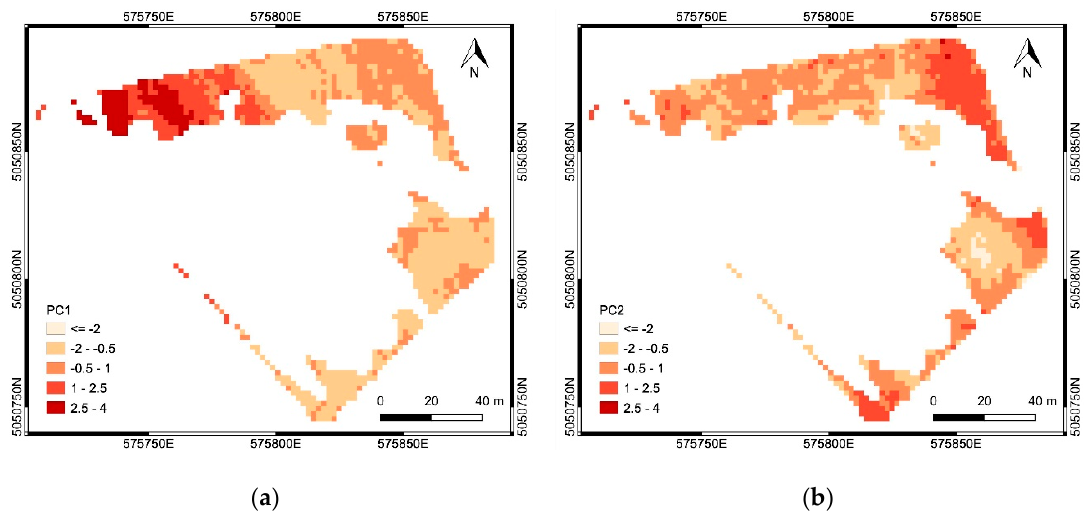
Figure 16. Results of the PCA applied in the area ‘b’: spatial distribution of PC b1 ( a ), PC b2 ( b ).